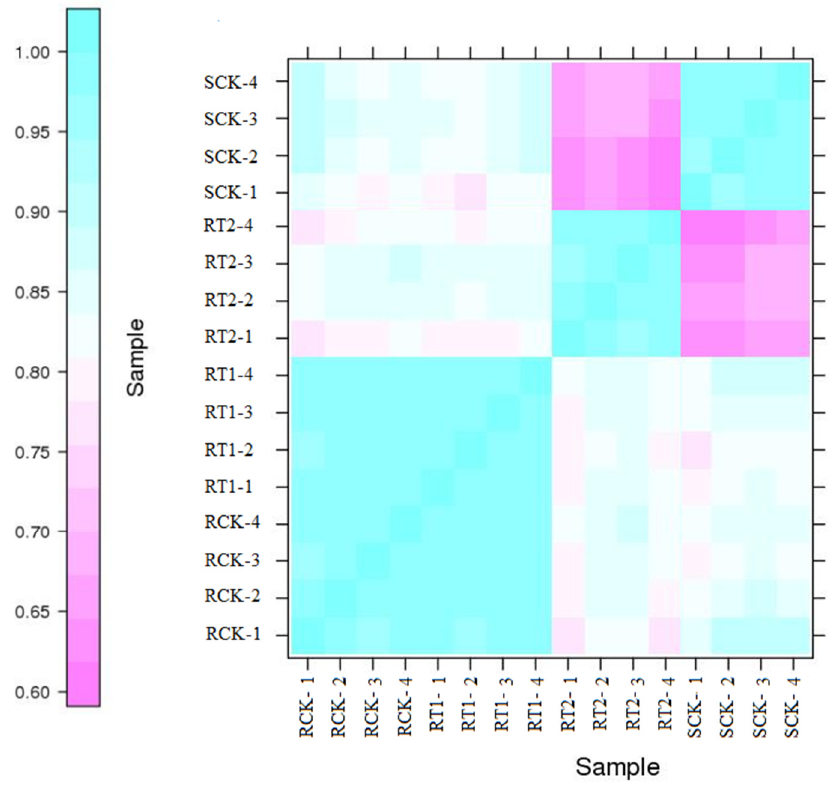
Figure 2. Heatmap of transcriptomic data correlation between different treatments. RCK: the untreated control of 9311; RT1: FE 45 g a.i. ha − 1 of 9311; RT2: FE 45 g a.i. ha − 1 +IH 180 g a.i. ha − 1 of 9311; SCK: the untreated control of MXZ.